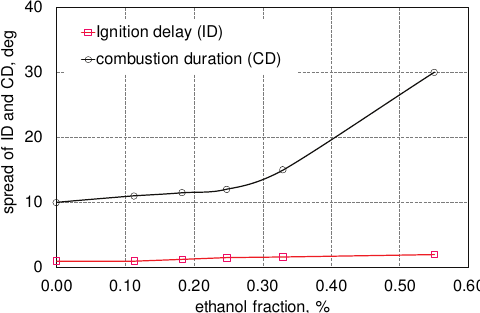
Fig. 9. Spread of ignition delay and combustion duration